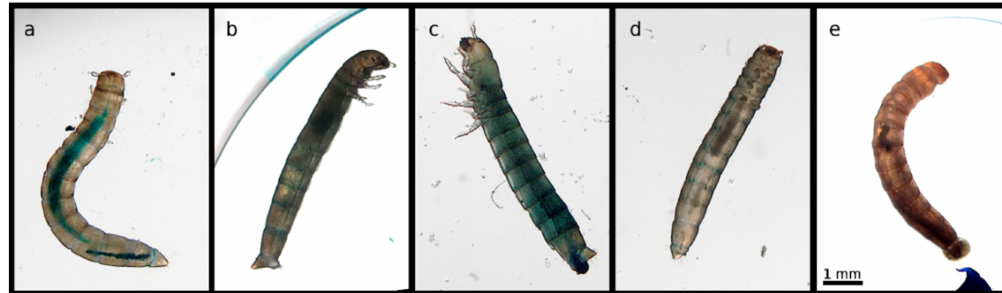
Figure 4. Phenotypes of T. molitor larvae observed under the experimental conditions. ( a ) Healthy control larva with a well-defined digestive tract filled with agarose and blue dye. Unlike ( b ), dead larva, showing a subtle Smurf phenotype upon exposure to B. thuringiensis. ( c ) Dead larva showing a stronger Smurf phenotype upon bacterial exposure. ( d ) Dead larva showing a darkened digestive